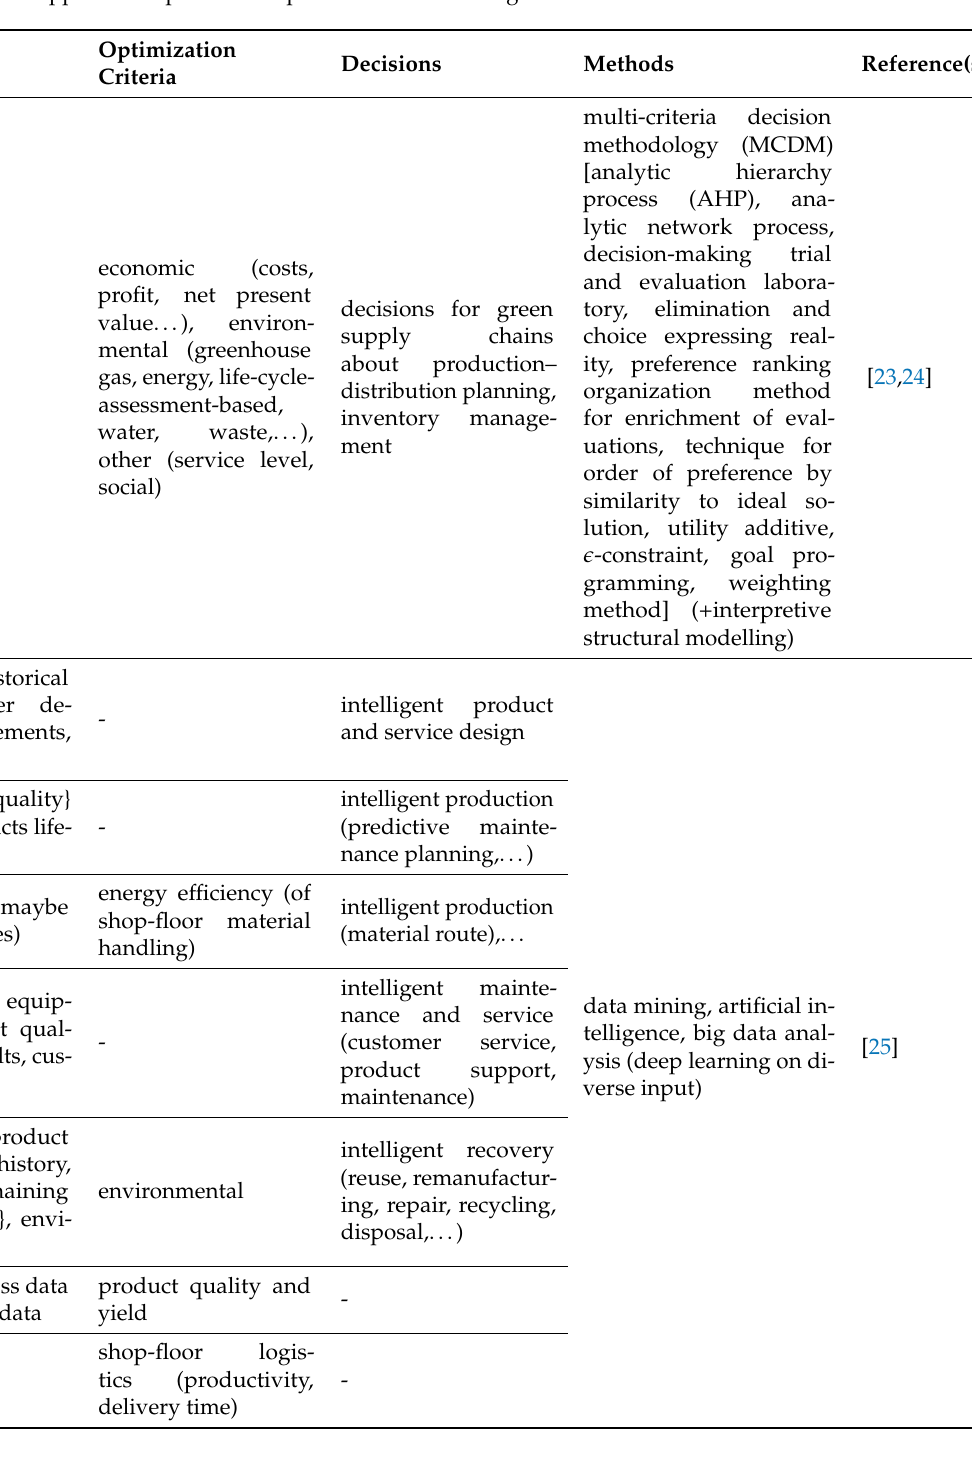
Table 1. Relation among data, KPIs, decisions and methods based on bibliography about decision support and optimization plans in